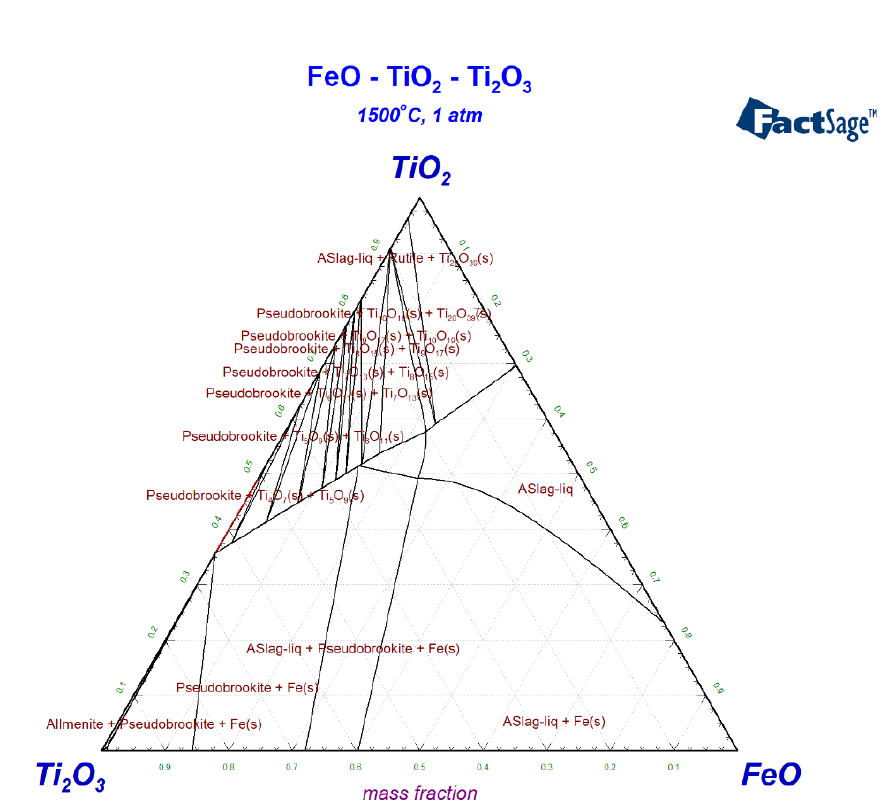
Figure 3. FeO-TiO 2 -Ti 2 O 3 ternary phase diagram at 1500 °C using FactSage version 6.4.